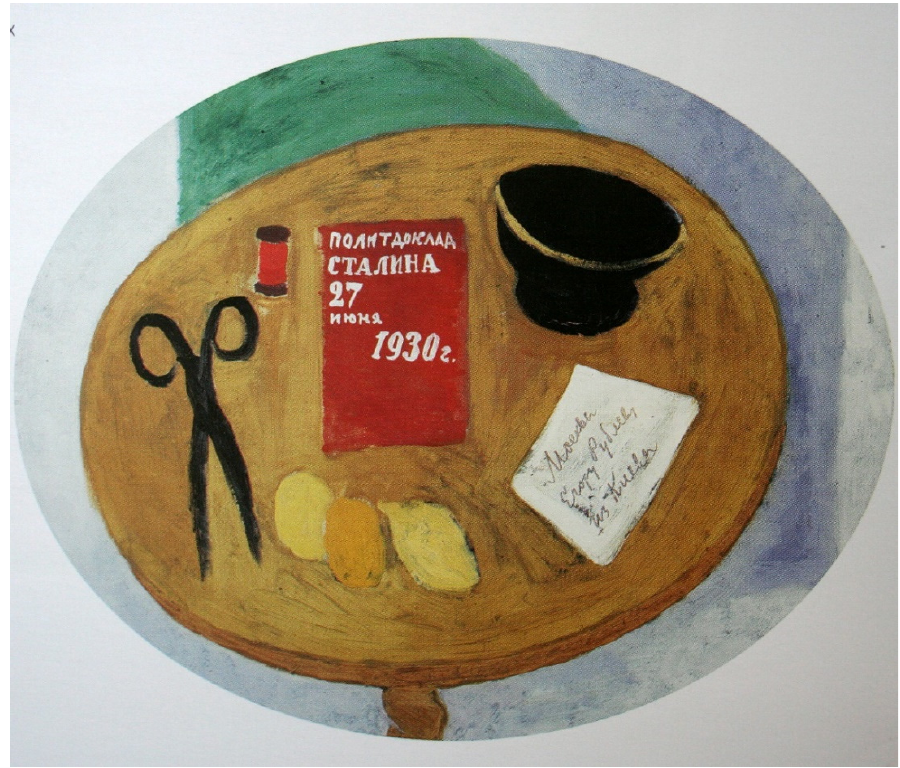
Figure 5. G. Rublev. The Letter from Kyiv . 1929.